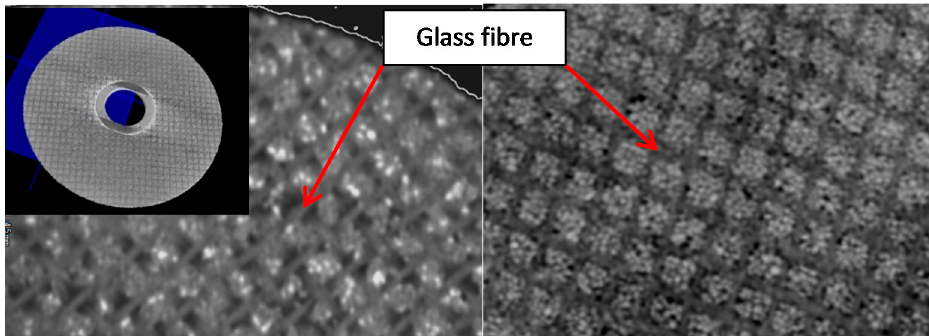
Figure 9. X-ray image of DE disc (shown top left corner) and PE disc.